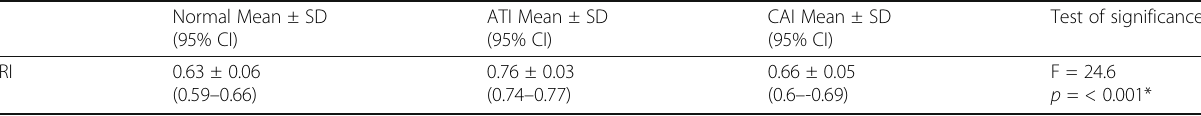
Table 5 Resistive index difference between the three studied groups